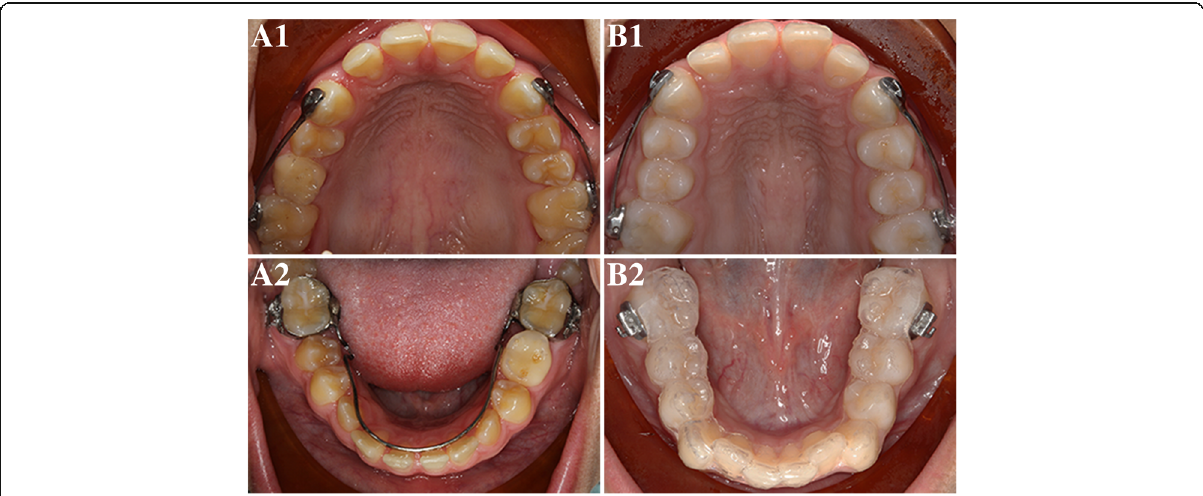
Fig. 1 Carriere Distalizer and appliance used for the lower arch . Carriere Distalizer functions to distalize the posterior segment as a unit (A1 and B1). The lower arch, either banded with a lower lingual holding arch (A2) or held together with a clear retainer (B2), serves as the main anchorage source for Class II correction. Depending on the length of Carriere Distalizer, elastics can be worn from the upper canines or premolars to the lower molars